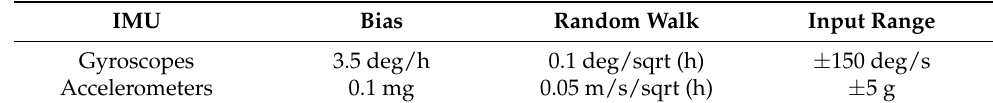
Table 1. The performance specifications of Epson G320N IMU.